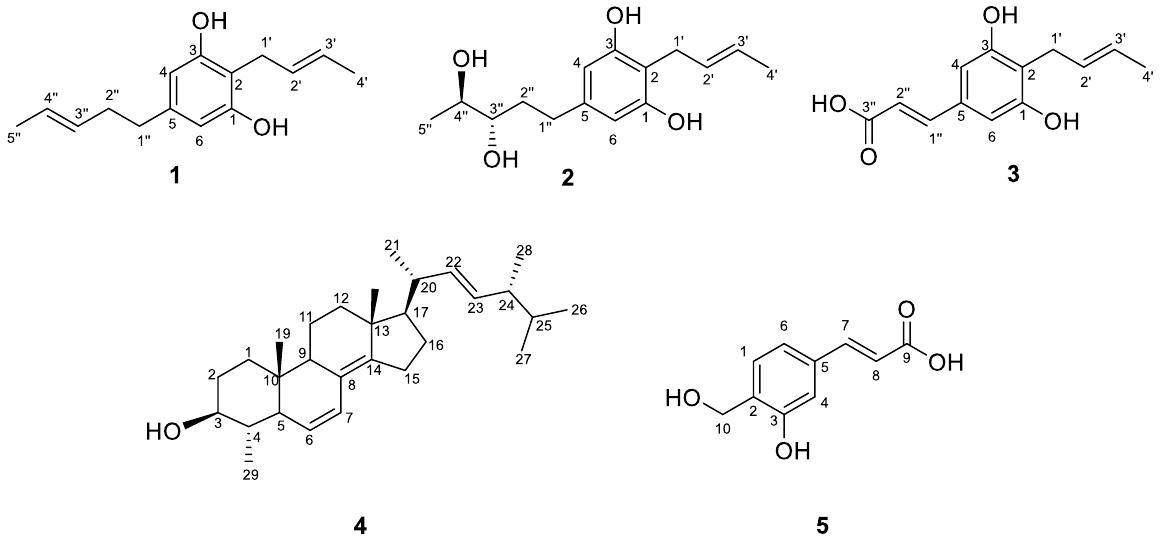
Figure 3. Structures of compounds 1 – 5 .